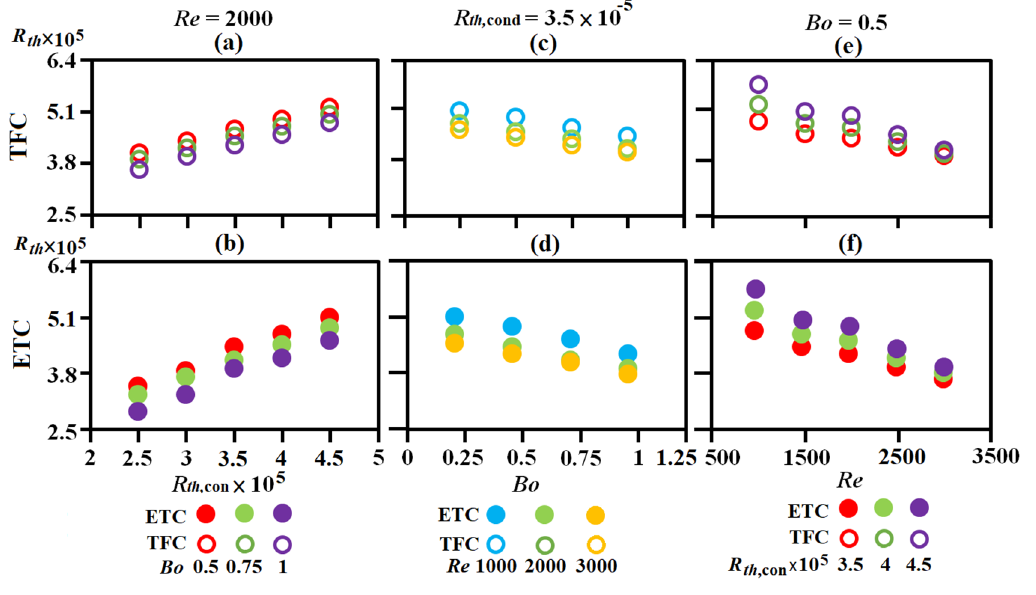
Figure 8. Variations of R th along with ( a , b ) R th ,con at Re = 2000 ( c , d ) Bo at R th ,con = 3.5 × 10 -5 . ( e , f ) Re at Bo = 0.5 between the loops with TFC and ETC.